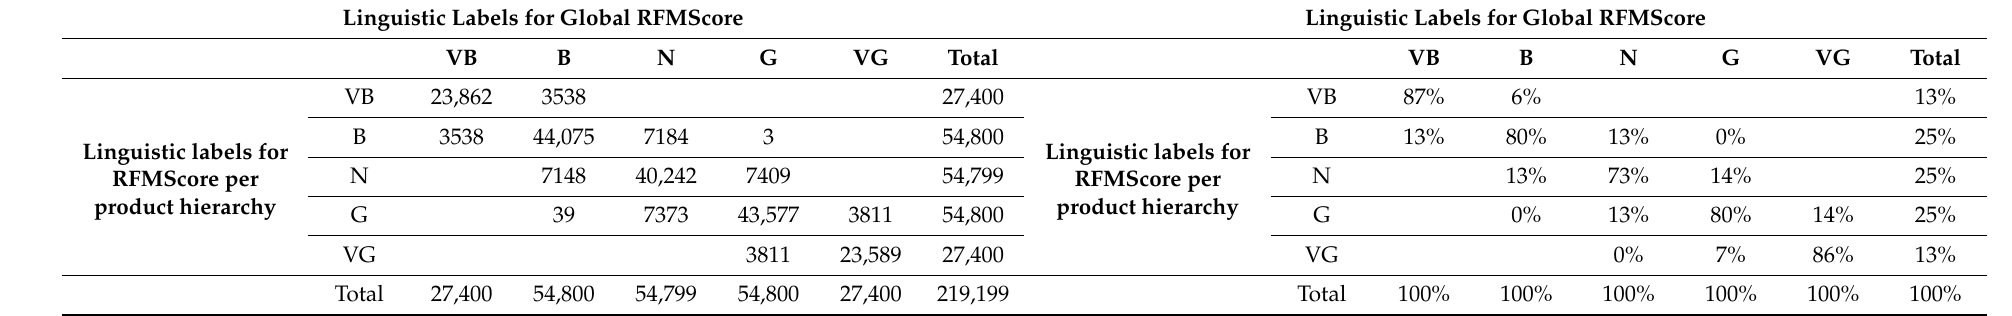
Table 7. Cross tables for linguistic labels of fuzzy RFMScore per product vs. fuzzy global RFMScore in a net amount and